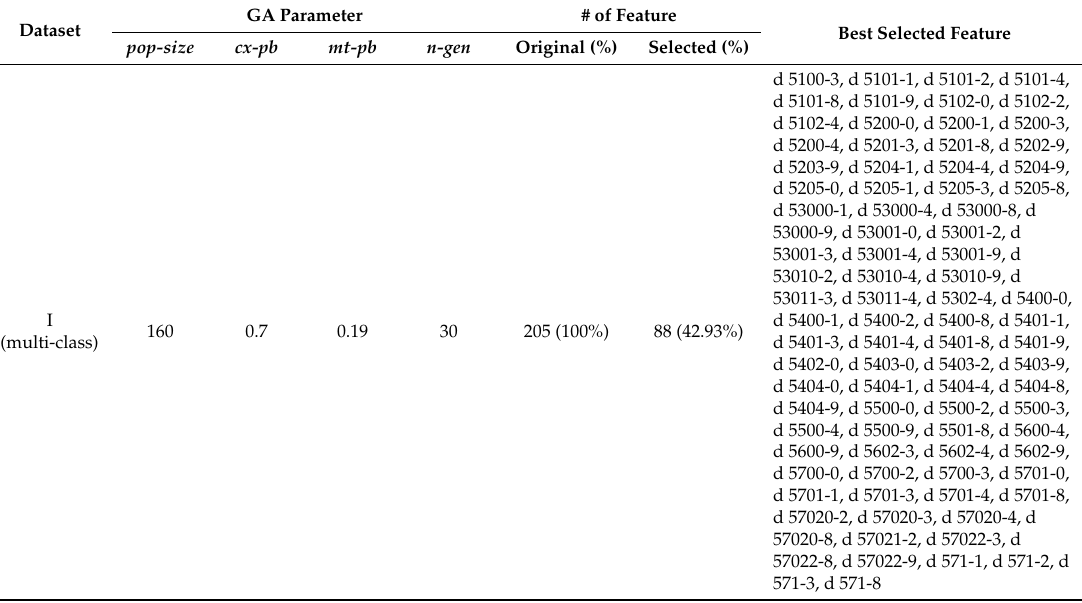
Table 4. Genetic algorithm parameters and its best selected features for each dataset used in this